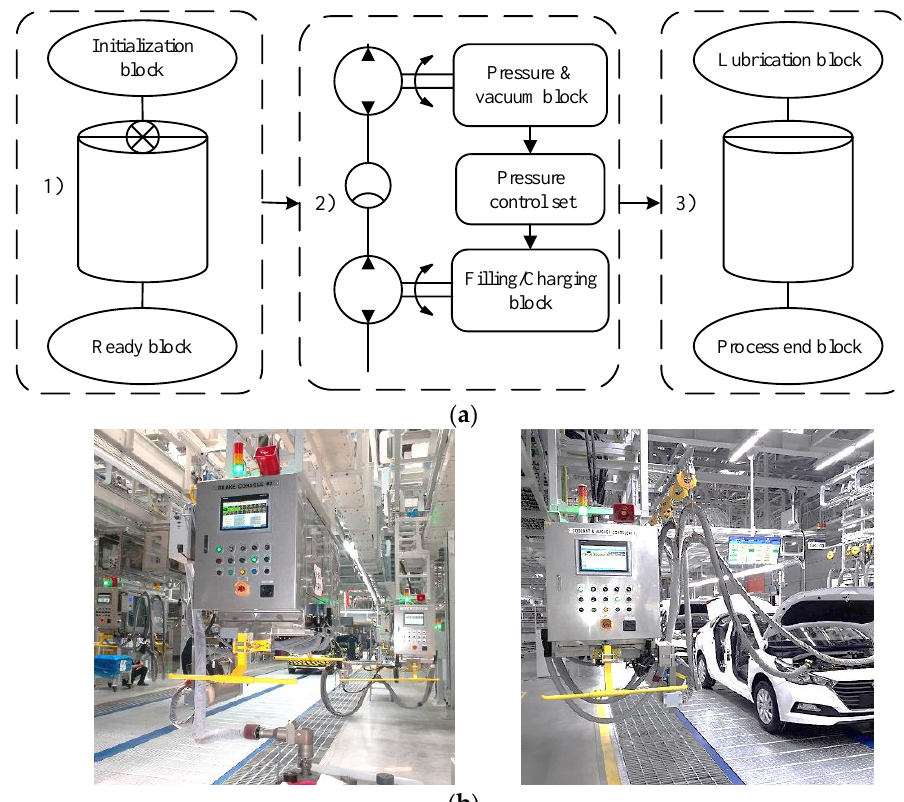
Figure 1. A filling system in an Iranian automotive assembly line. ( a ) Block diagram, and ( b ) functioning view.